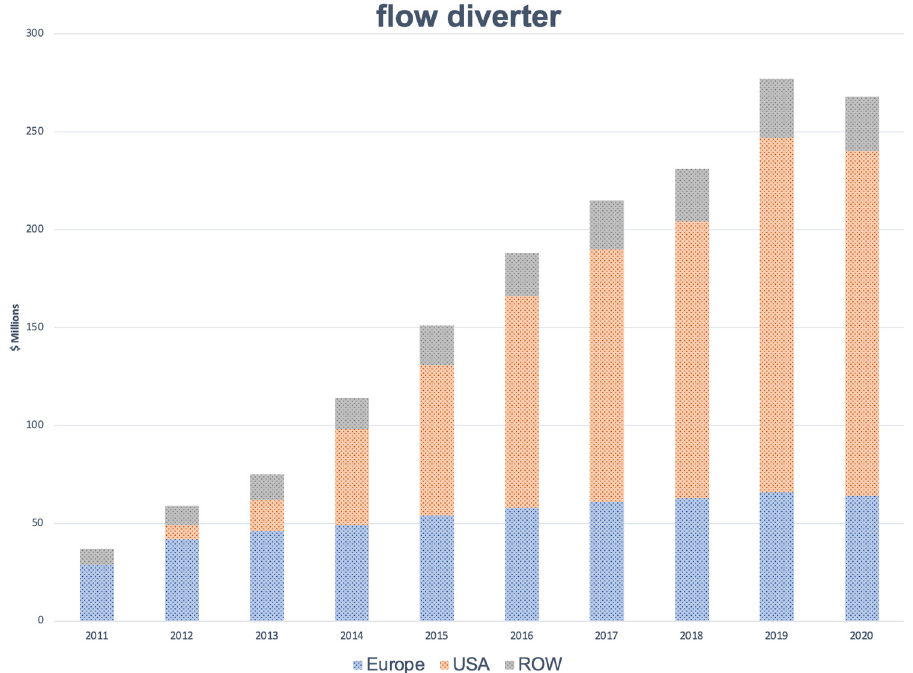
Figure 2. Annual revenues (in millions USD) associated with the use of flow diverters in Europe, the USA, the rest of the world (ROW), and globally (total) from 2011 through 2020. Data were collected from industry sources.